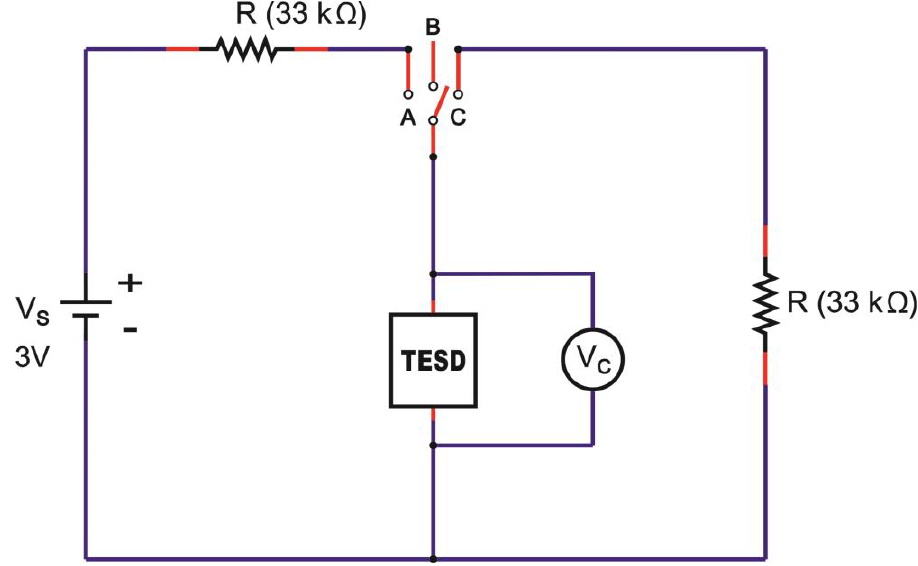
Figure 3. Schematic diagram of charge-discharge measurements set up.